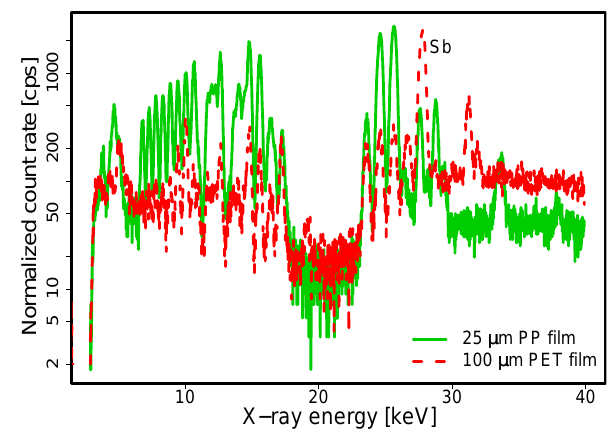
Fig. 7. Comparison of SR-XRF spectra of two different calibration films: count rate of elements in the Merck IV standard solution on a 100-µm PET film and the count rate of essentially the same solution on a 25-µm PP film. Count rates measured at HASYLAB are normalized to photon flux and detector dead